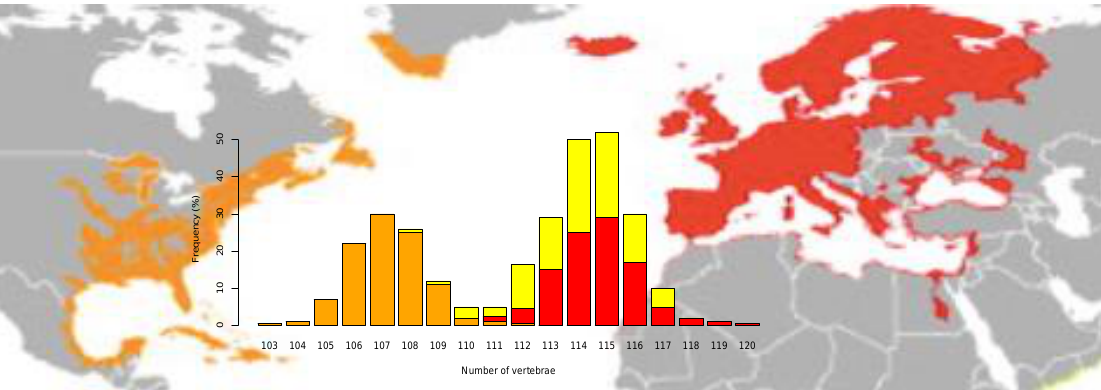
Figure 1. Vertebrae counts in European eel (red), American eel (orange) and Icelandic individuals (yellow) after re-examining data from Avise et al. [44]. Geographic distribution for each species is adapted from Jacoby et al. [54].